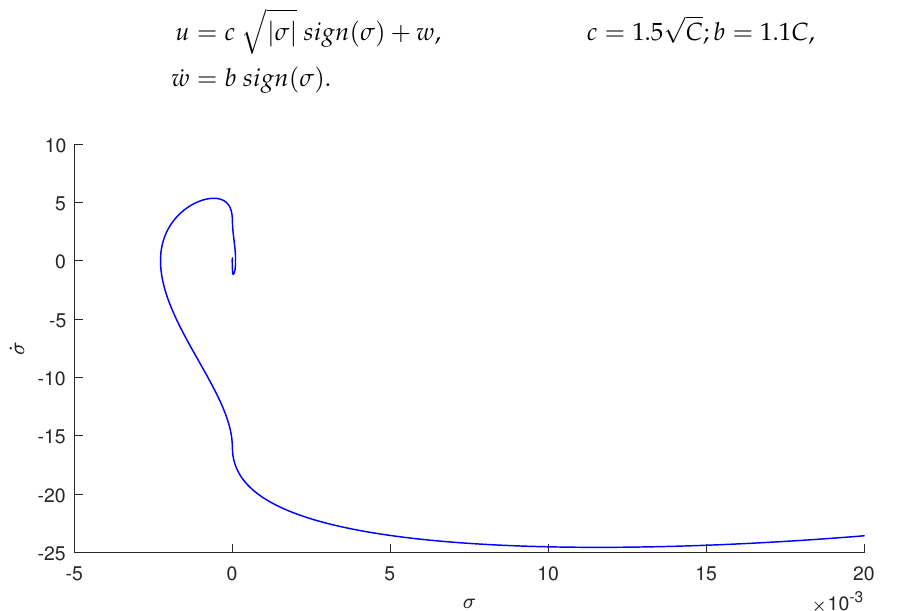
Figure 5. Trajectory of σ over ˙ σ with super twisting controller from Equation (38)